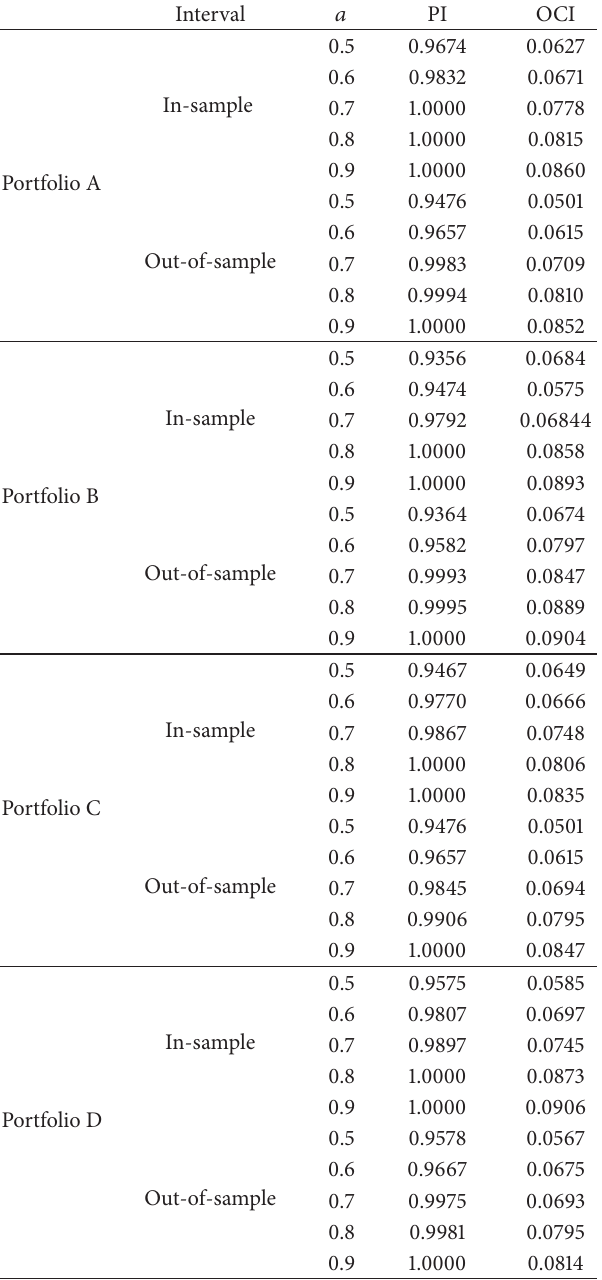
Table 6: Effectiveness of our method under different relative risk aversion